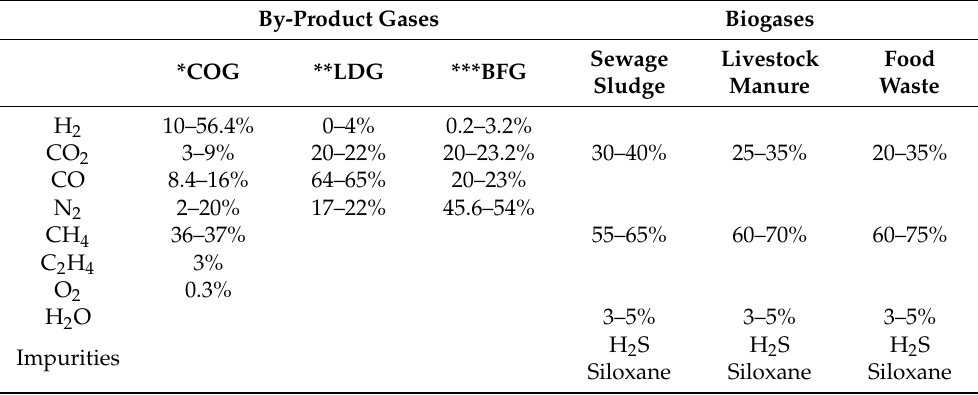
Table 1. Composition of by-product gases and biogases.